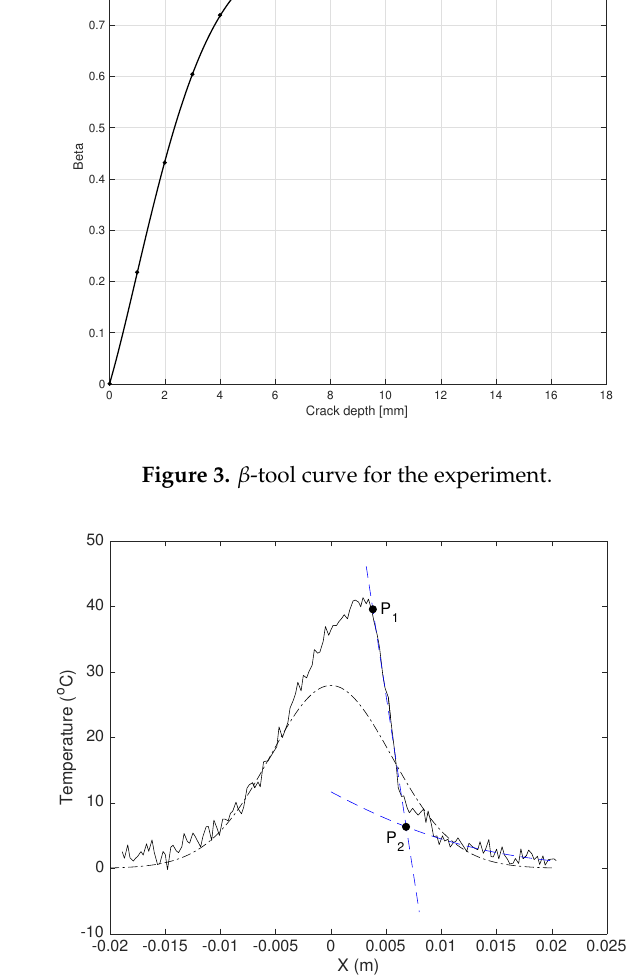
Figure 4. 2D Temperature across the crack (solid line) and background temperature (dash-dot